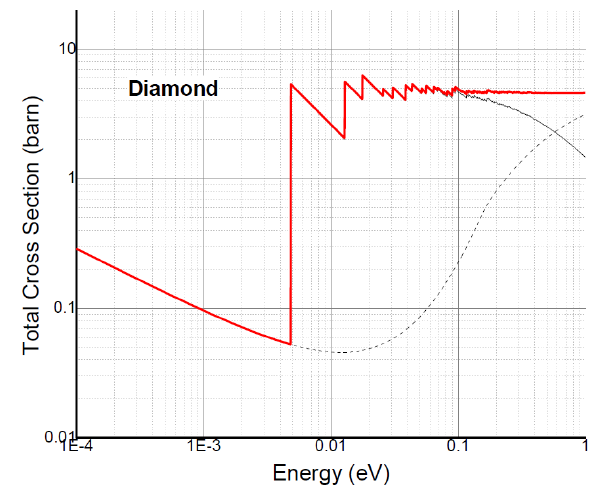
Fig. 2 : The total cross section of bulk diamond over the thermal neutron energy range (red line). The black dashed line denotes the inelastic contribution, whereas the black solid line represents the elastic coherent component.